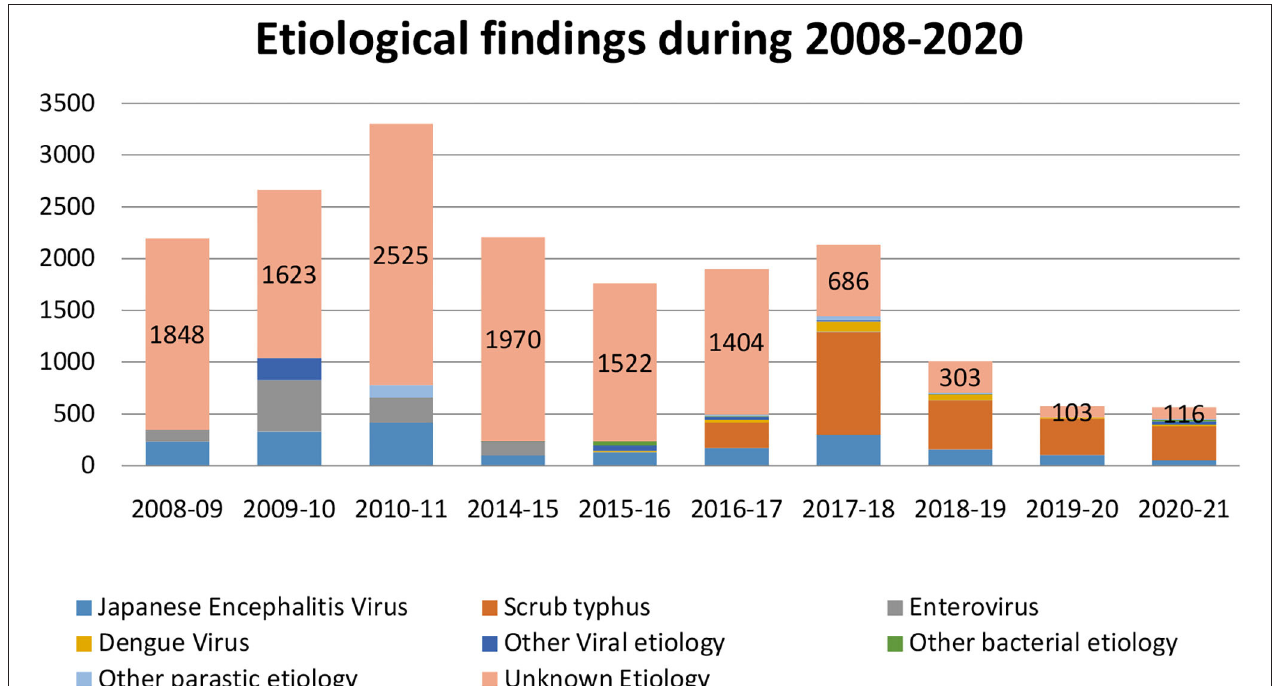
FIGURE 3 | Graphical representation of aetiological investigations of AES cases during 1978–2020. In the year 2004, ICMR- NIV, Pune, started encephalitis outbreak investigations in Gorakhpur district of eastern UP, India. In 2008, field unit of ICMR-NIV, Pune, established in campus of Baba Raghav Das Medical College, Gorakhpur, for routine AES diagnosis and research. Decline in burden of unexplained AES cases can be observed.